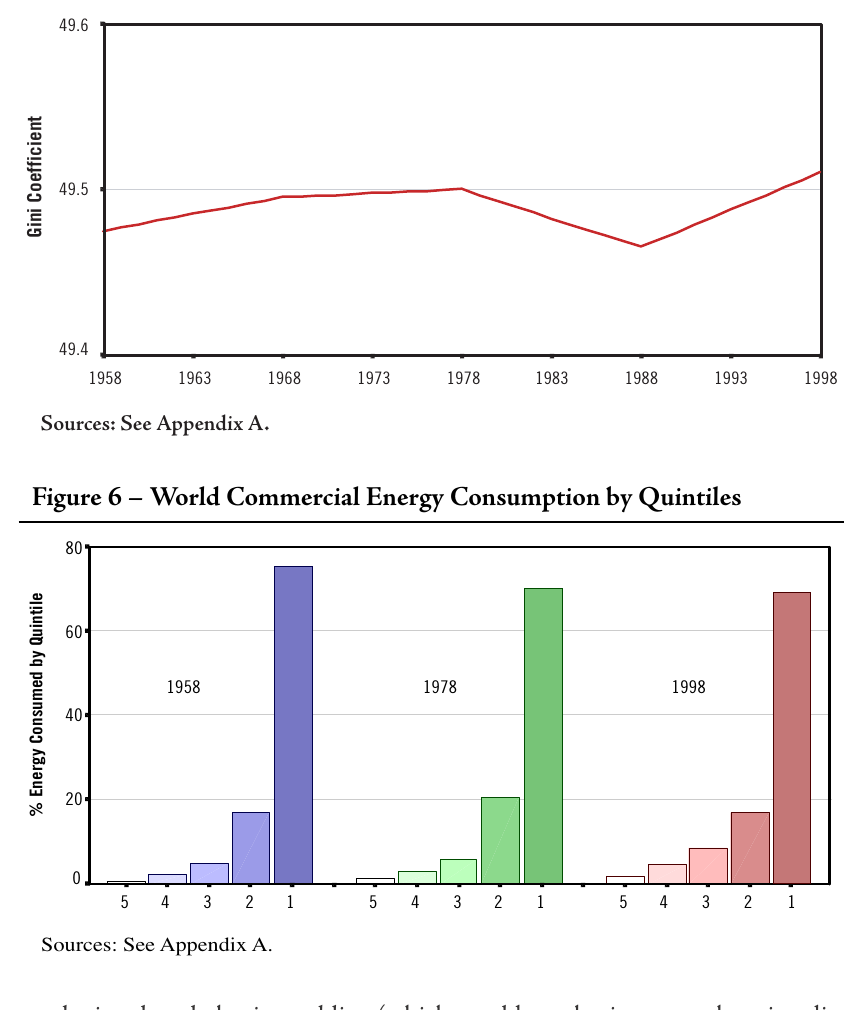
Figure 5 – World Energy Gini Coefficient, 1958–1998